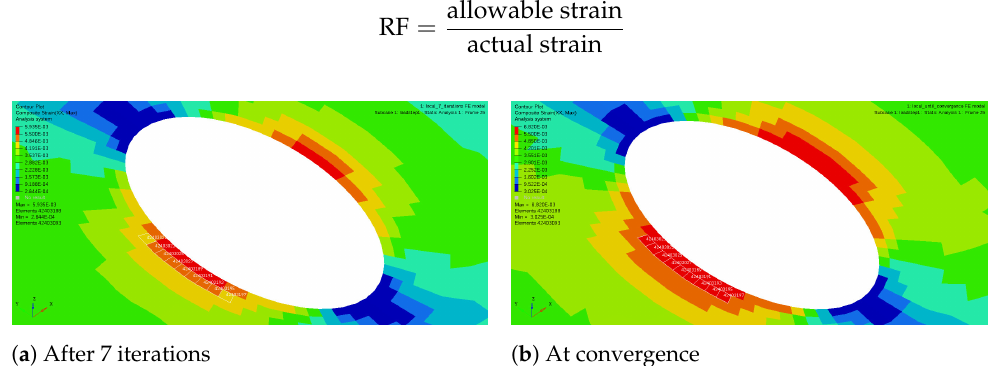
Figure 23. Violation of strain constraints in the local